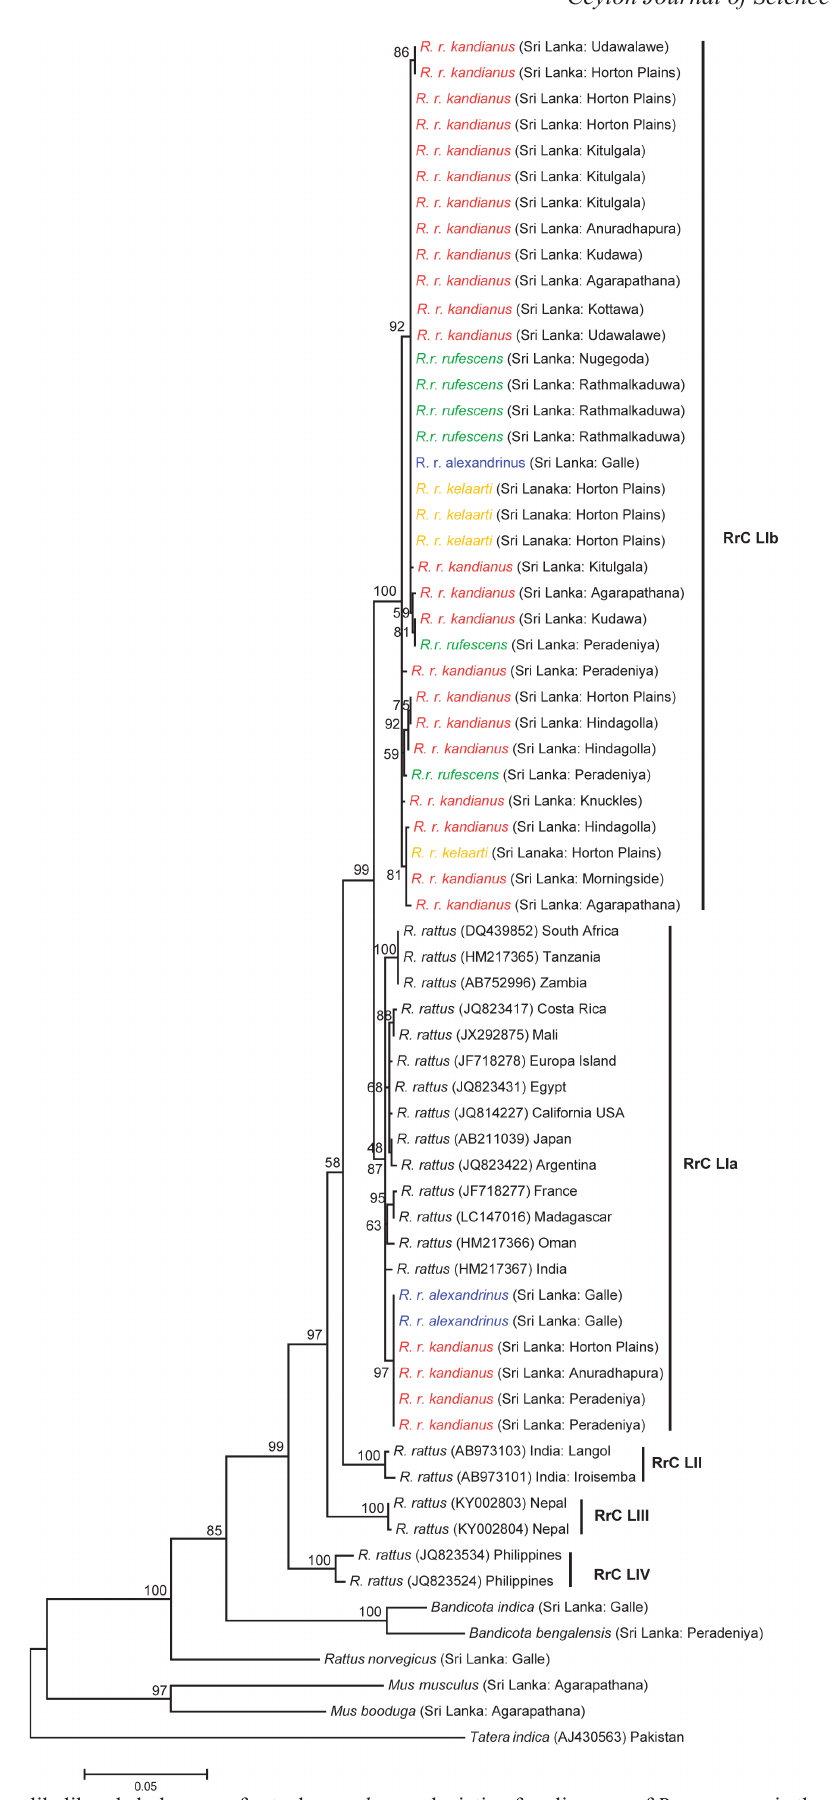
Figure 2: Maximum likelihood phylogram of cytochrome- b gene depicting four lineages of Rattus rattus in the world and the placement of the R. rattus subspecies of Sri Lanka. Bootstrap values are presented on the